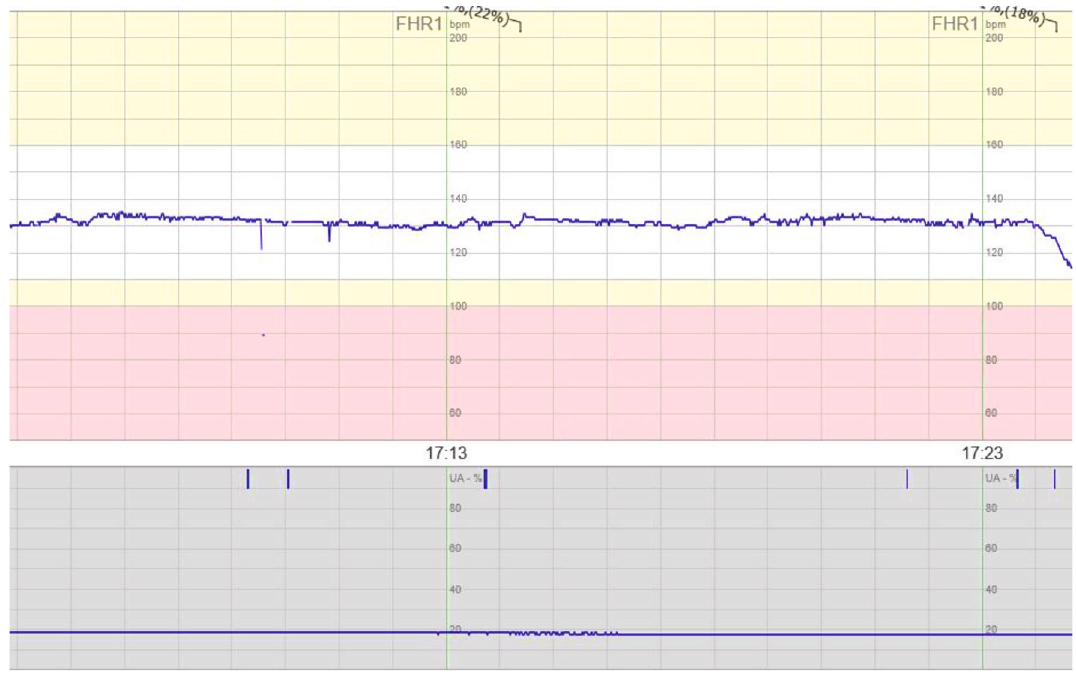
Figure 3: Patient 3 CTG at admittance to the hospital.